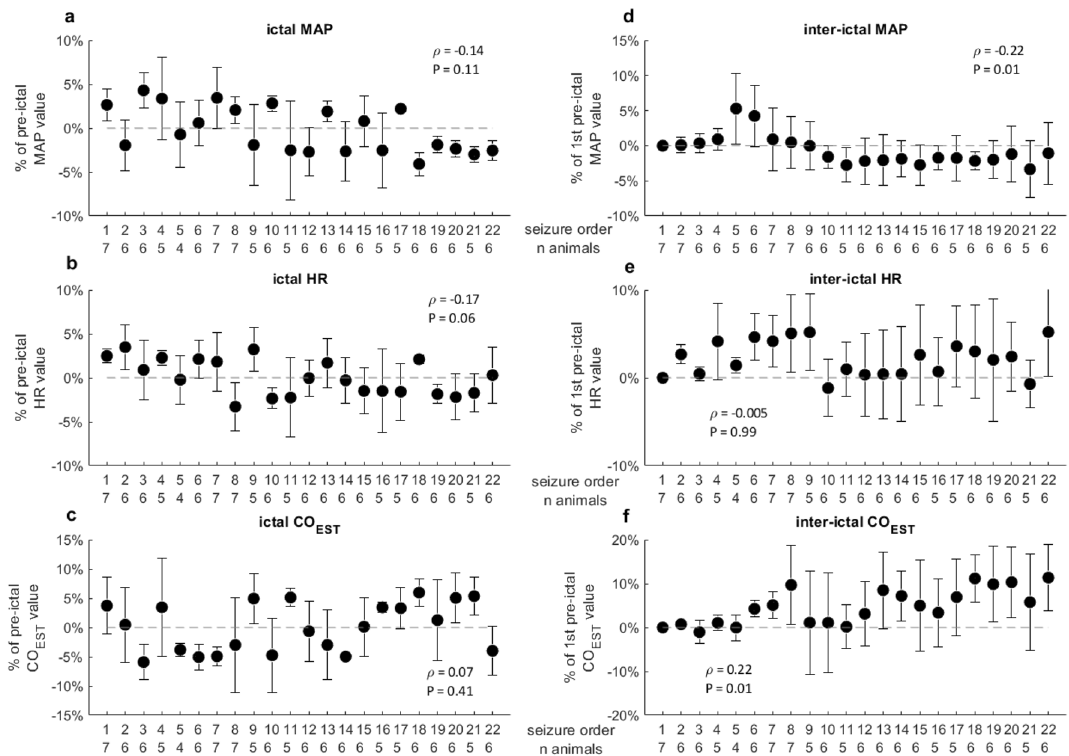
Figure 2. Variation of inter-ictal and ictal systemic parameters with seizure recurrence. MAP Mean arterial pressure, HR Heart rate, CO EST Cardiac output estimation using the Liljestrand–Zander method. For inter-ictal and ictal peak calculation please refer to the text. In abscissa, the seizure rank and the number of animals whose seizure was available for each rank. Data are presented as median ± median absolute deviation. The indicated Spearman’s rank-order correlation coefficient ρ and the corresponding p value are calculated using all available seizures. A non-significant decrease in the median value of both ictal MAP (ρ = − 0.14, P = 0.11; ( a ) and ictal HR (ρ = − 0.17, P = 0.06; ( b ) occurred while the ictal CO EST response was not influenced by seizure recurrence ( c ). The inter-ictal MAP value significantly decreased as seizures recurred (ρ = − 0.22, P = 0.01; ( d ). Conversely a positive trend was observed for the inter-ictal CO EST (ρ = 0.22, P = 0.01, ( f